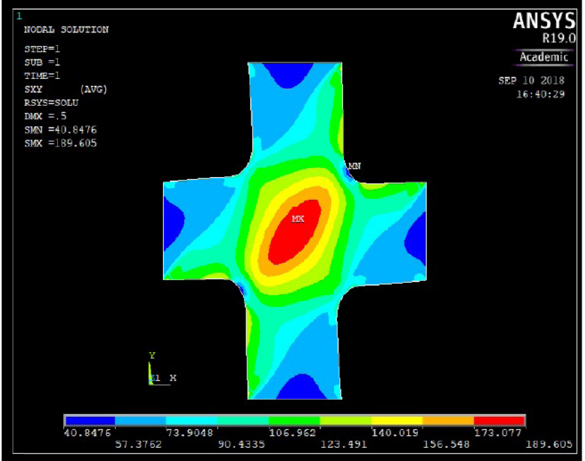
Figure 12: σ 12 contour plot in the cruciform